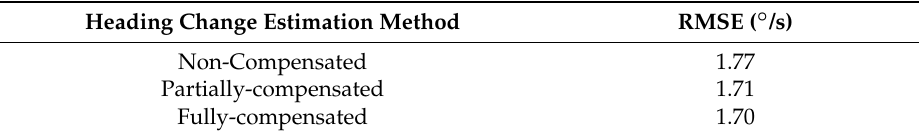
Table 2. RMSE of the different change of heading estimation